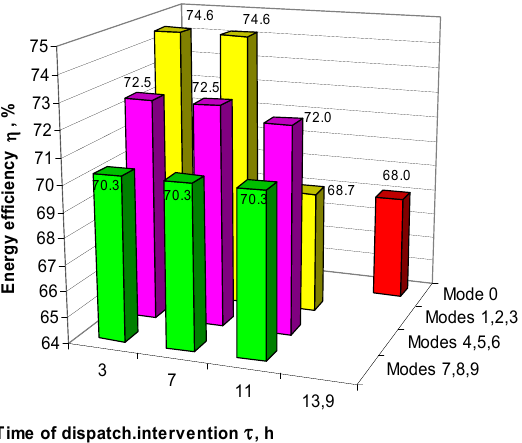
Figure 8. Change in η of the studied modes, depending on t m1 and τ .